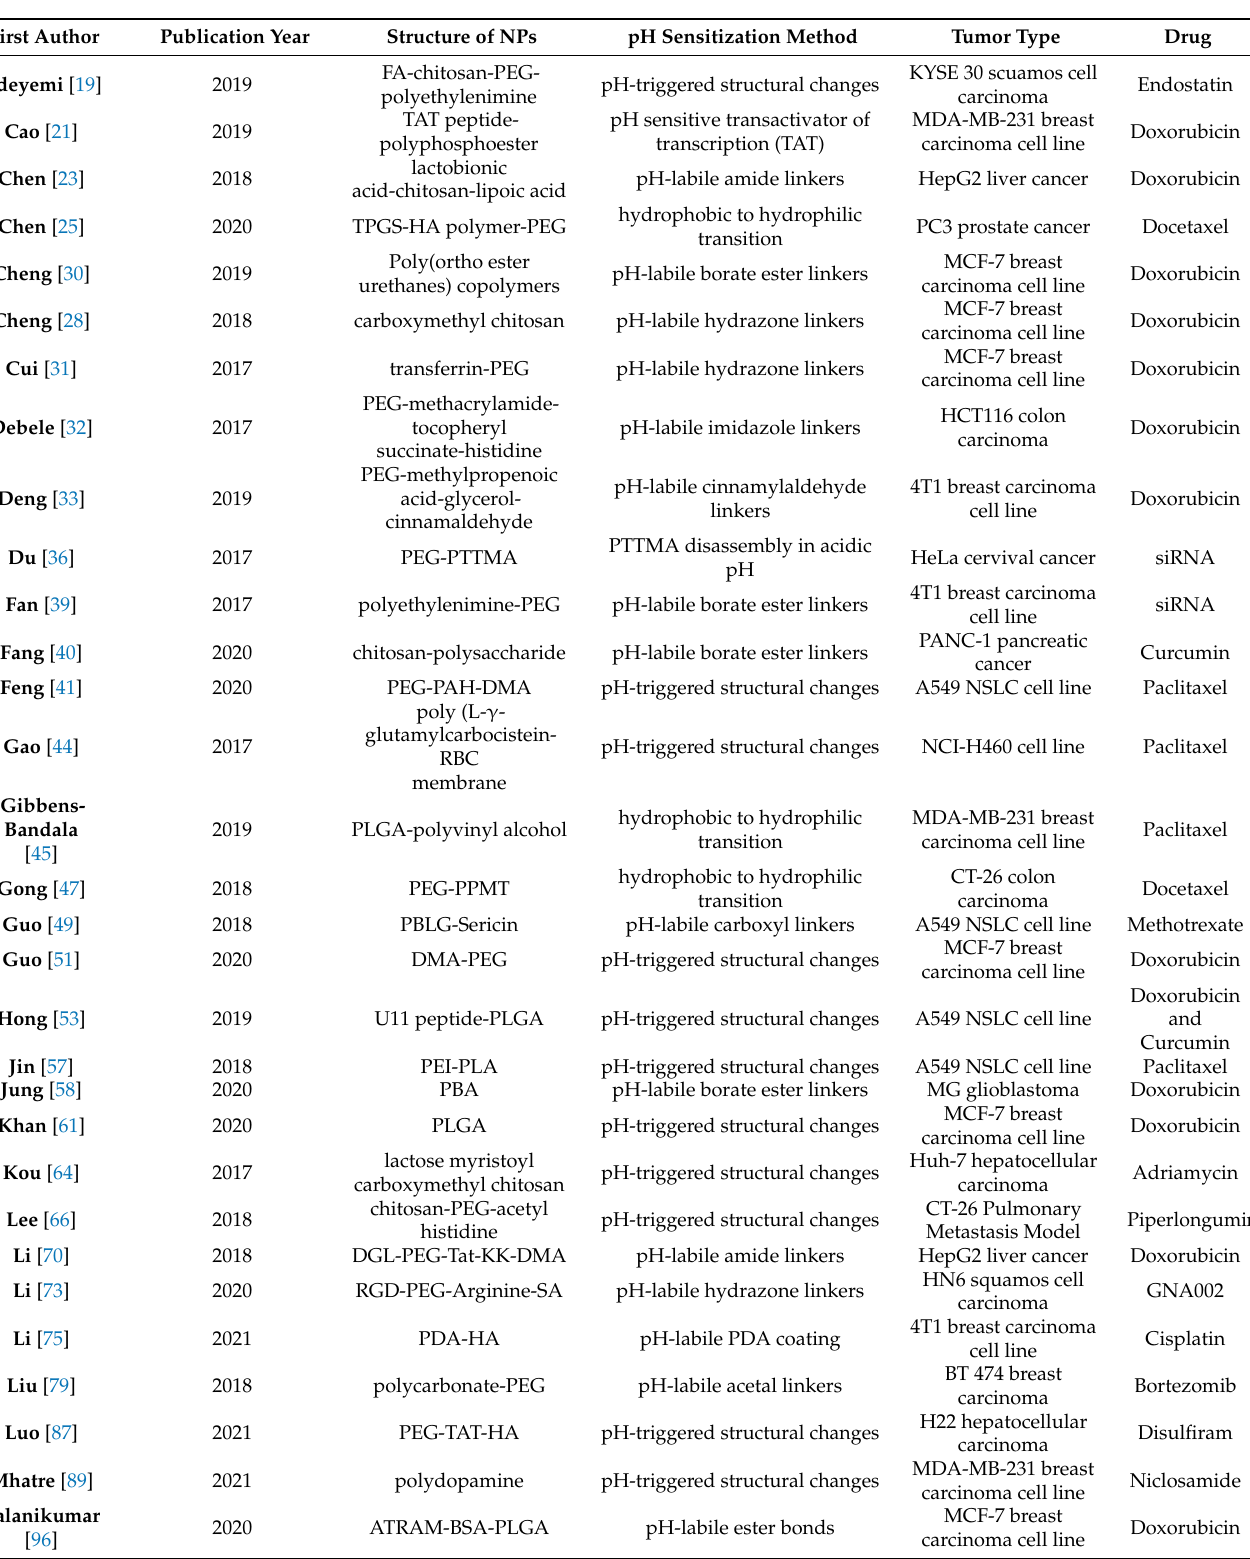
Table 3. Overview of polymeric NPs: structure, pH sensitization method, tumor type, and delivered